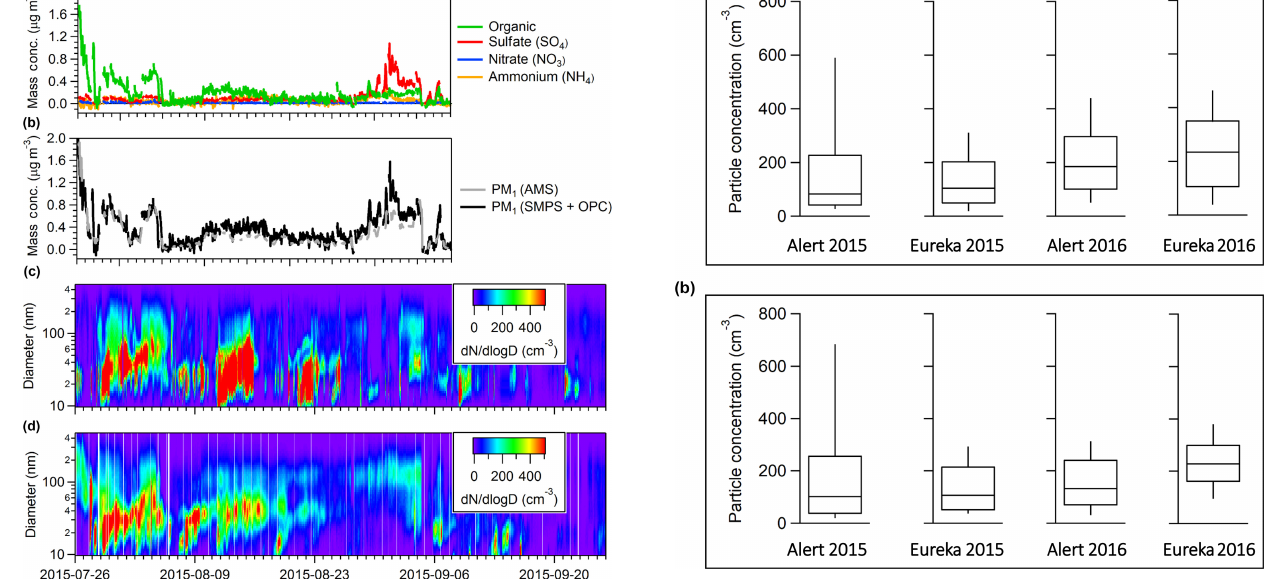
Figure 3. Aerosol mass spectrometry measurements of aerosol composition taken at the PEARL RidgeLab near Eureka (a) . The total concentration of non-refractory PM 1 aerosol measured by the mass spectrometer is also compared against the total PM 1 concen- tration measured by the SMPS and OPC, and it exhibits good agree- ment with a linear regression analysis yielding a slope of 1.16 and a correlation coefficient of 0.89 (b) . In addition, the size-resolved particle concentration measured by SMPS instruments during sum- mer 2015 at Alert (c) and at the PEARL RidgeLab (d) are shown. The sizes are mobility diameters measured by an SMPS, which are equal to the physical diameters under the assumption that the parti- cles were spherical and contained no voids. All data are plotted on the same timescale.